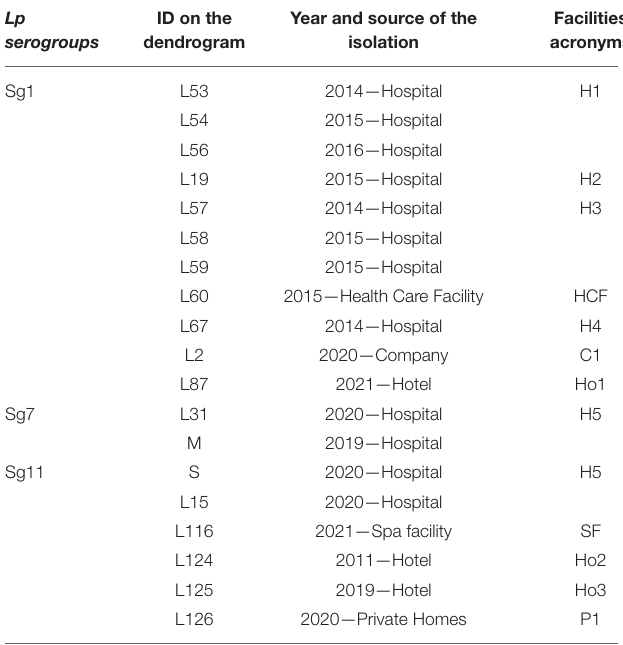
TABLE 3 | Isolates ID with their source, year of isolation, and respective acronyms reported in the dendrograms. Lp ID on the serogroups